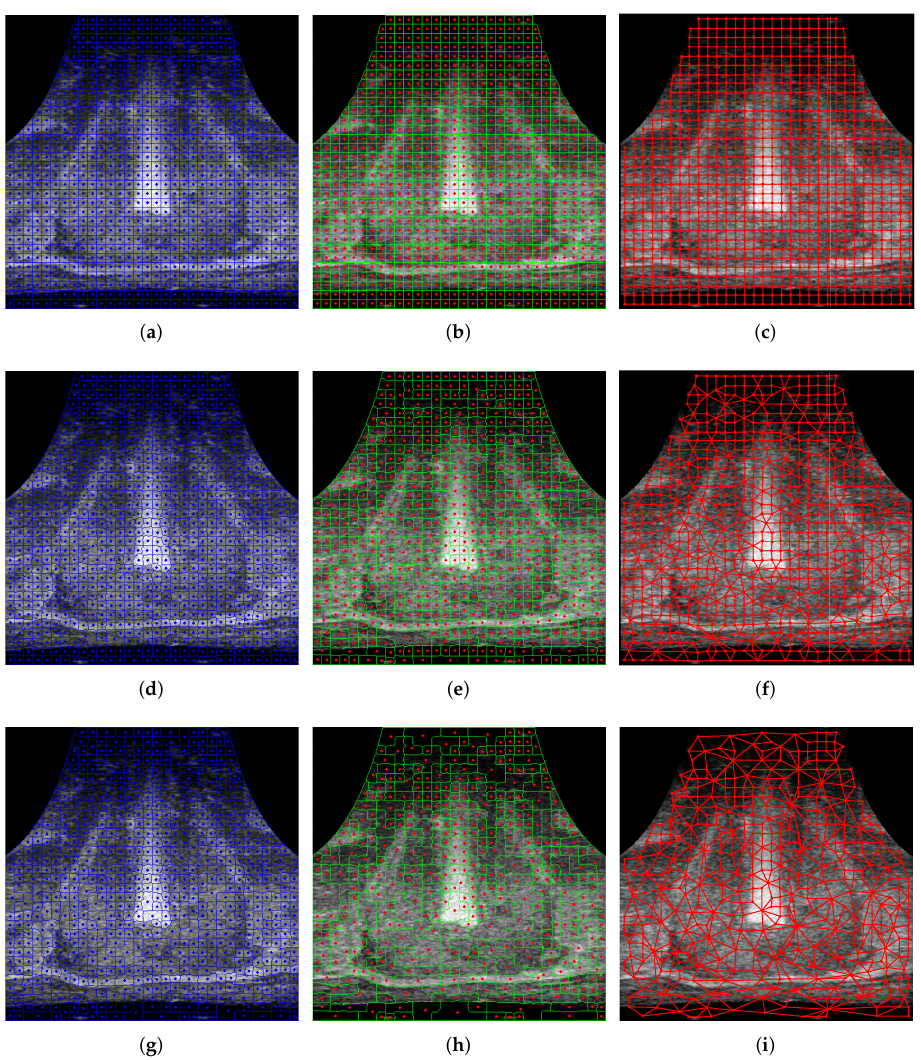
Figure 6. Pixel clusters, superpixel regions, and adjacency graph at initialization of superpixel al- gorithm, after five cluster update and region update iterations, and after the final update